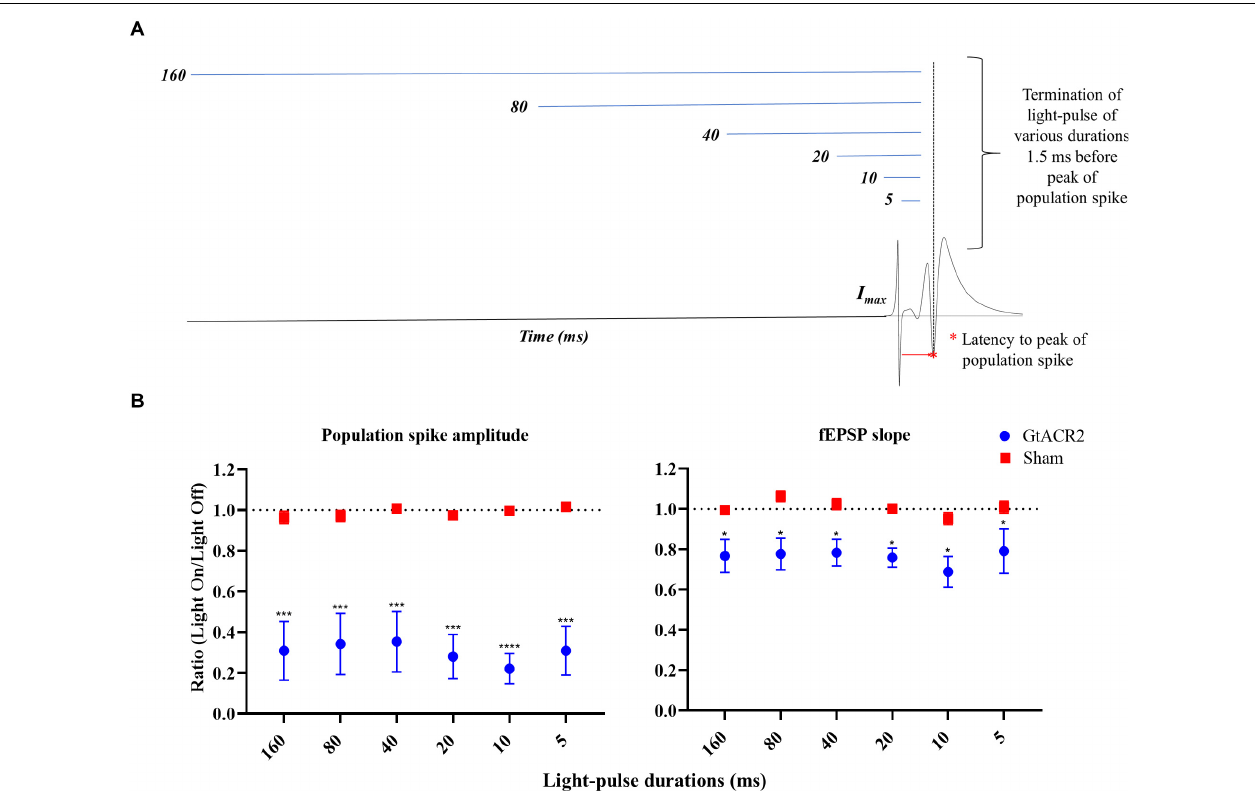
FIGURE 5 | Effect of light-pulse durations on CA1 EPs. (A) Schematic of the experimental paradigm. (B) The GtACR2-mediated inhibition of EPs was maintained at increasing the light-pulse durations; there was no significant increase of the effect on population spike ( n = 6) and fEPSP slope ( n = 5). Mean of the EP light-on/light-off condition parameters’ ratios and the corresponding standard error (SEM) are plotted against for light-pulse durations. A significant difference between the groups was found. * p ≤ 0.05, *** p < 0.0005, and **** p <